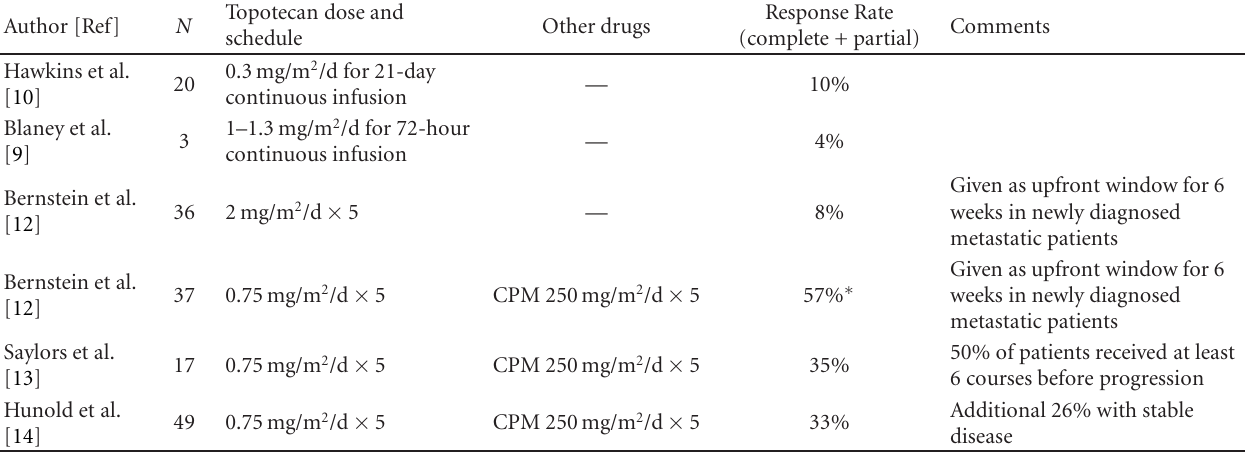
Table 1: Summary of selected studies using topotecan-based therapy for patients with relapsed/refractory Ewing